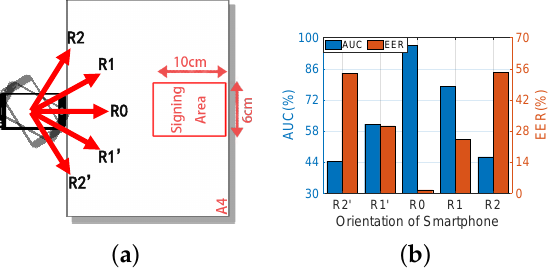
Figure 13. The performance when placing the smartphone at different orientations. ( a ) The experi- mental setup of different orientations. ( b ) The AUC and EER in different